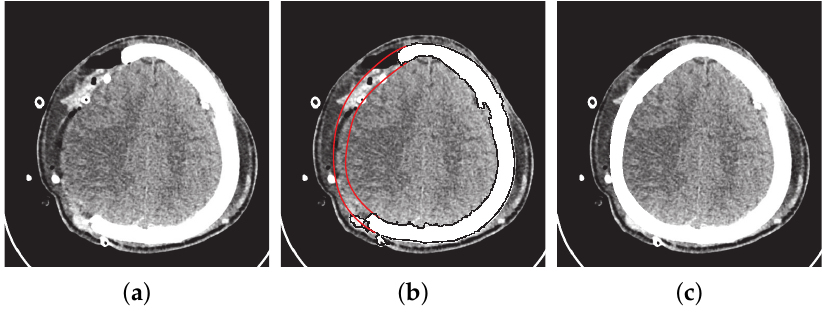
Figure 9. Construction of fractured part using NURBS curves. ( a ) Original image. ( b ) Fractured part boundary curves reconstruction (red curves show the inner and outer boundary curves). ( c ) Recon- struction of fracture part into DICOM